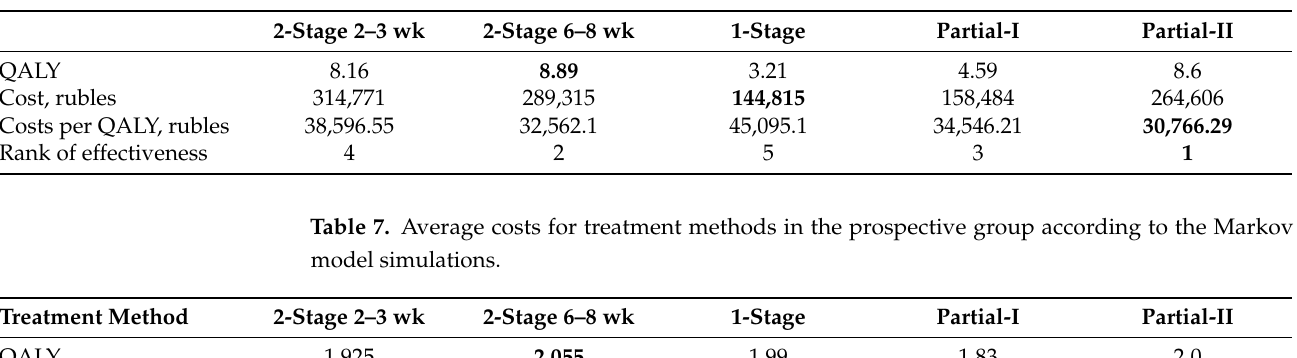
Table 6. Average costs for treatment methods in the prospective group according to the decision trees.